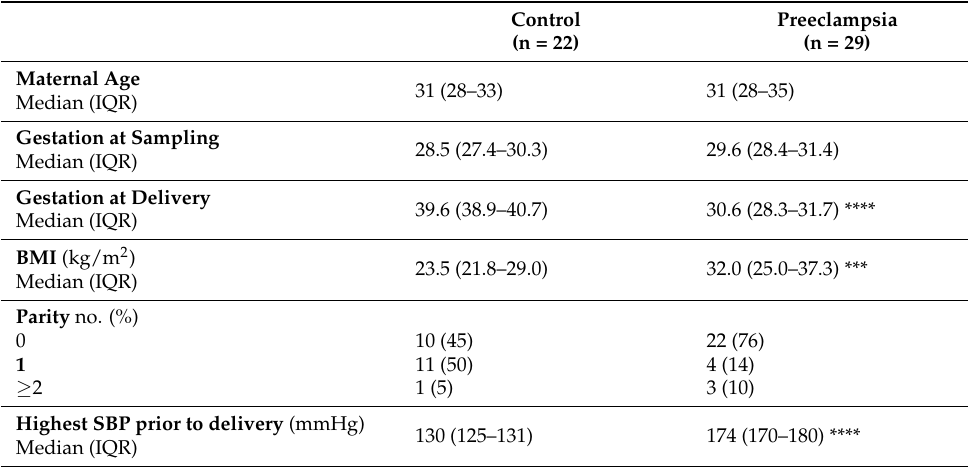
Table 1. Patient characteristics for collected plasma